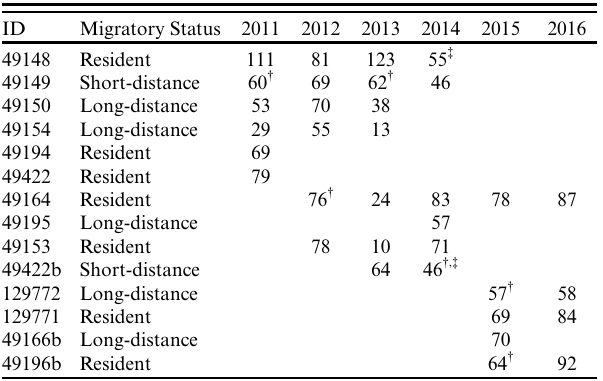
Table 1 . Number of consecutive days an adult Reddish Egret ( Egretta rufescens ) was at a specific colony in the Laguna Madre, Texas, during the breeding period in 2011–2016 (< 36 days likely indicates a nest failure).